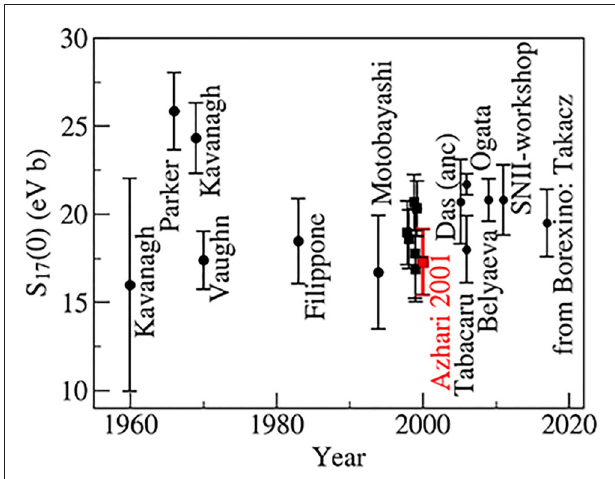
FIGURE 7 | History of the determination of astrophysical S 17 (0). The value measured in the experiment, discussed in the text, is in red and labeled “Azhari 2001.” For details see ( Azhari et al., 2001).